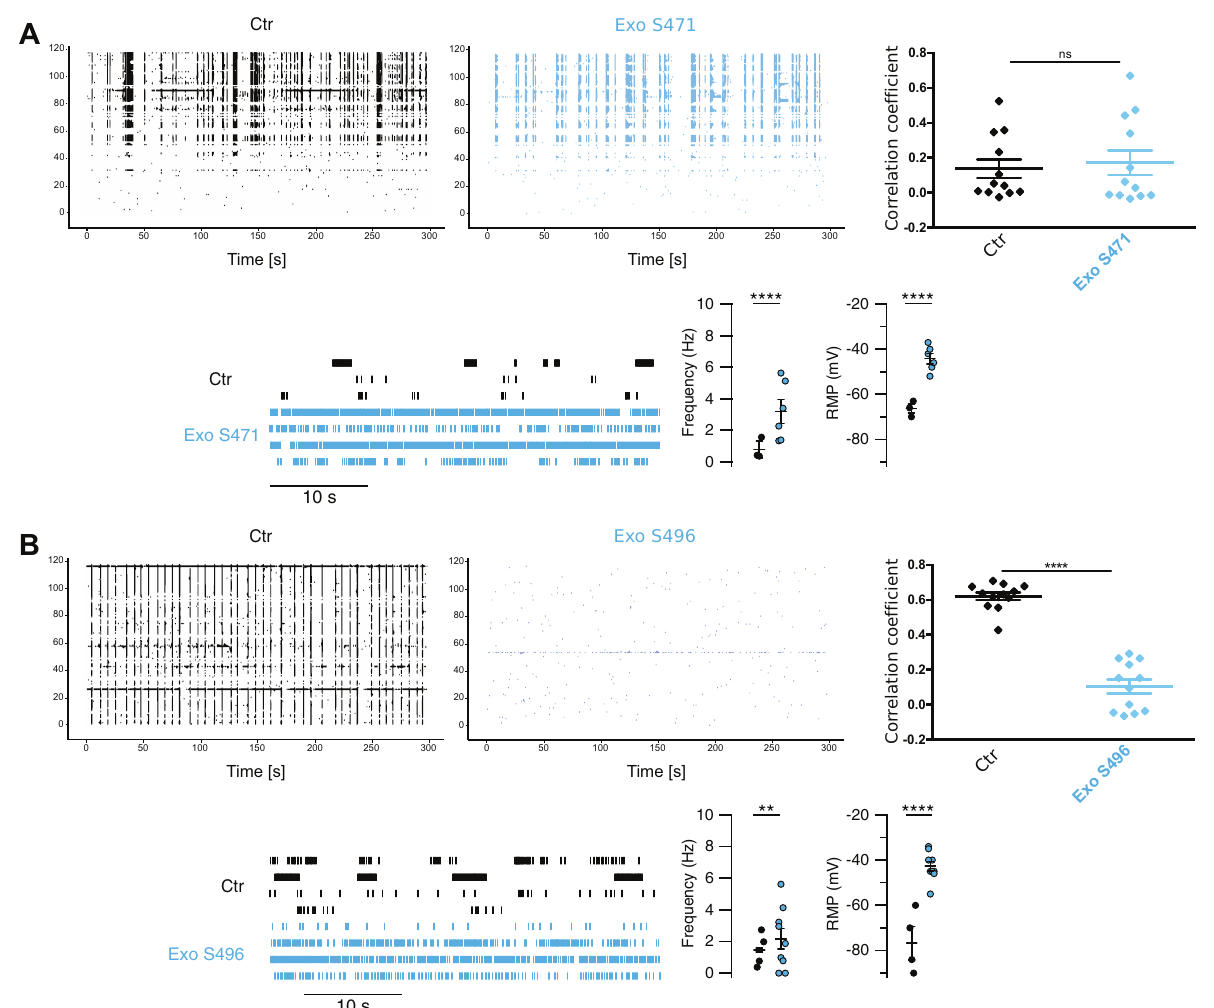
Fig. 7 Exosomes derived from HGG patients have variable effects on neuronal excitability and synchrony. Network-wide and single-cell electrophysiological phenotype of neurons treated with exosomes from HGG patients ( A : S471; B : S496). Raster plots from MEA recordings and correlation coef fi cients among spike times are shown in the upper panels, before (Ctr, black) and 24 h after exosome incubation (Exo, blue). The y axes on the raster plots represent channels ’ numbers. The average correlation values across 10 channels were calculated and their distribution compared using Wilcoxon – Mann – Whitney U test; ** p < 0.001, **** p < 0.0001; n = 12, average of 10 channels. In the lower panels, raster plots of single-cell neuronal activity are shown for neurons treated with patients ’ exosomes and the respective controls. The distributions of fi ring rate (Hz) and resting membrane potentials (RMP) are shown; statistics were performed using the Wilcoxon – Mann – Whitney U test; ** p < 0.001, **** p < 0.0001; n = 3/6 for S471, 4/9 for S496 (neurons analyzed in Ctr/Exo samples, respectively). (Fig. 6A – C, blue traces, upper middle panels ): the correlation coef fi cient among spike times was signi fi cantly decreased in all three cases (Fig. 6A – C, upper right graphs ). These results are consistent with the ones obtained from U87 exosomes (Fig. 2). In the case of exosomes derived from patient S479, we observed large waves of electrical activity invading the entire network: these ‘ superbursts ’ appeared to be the collective expression at the network level of the pro-epileptic behavior induced by exosomes at the single cell level (see Fig. 3). Given the lower heterogeneity of hippocampal neurons in culture compared to that of cortical neurons [42, 43], we performed intracellular recordings on hippocampal neurons treated under the same experimental conditions. Neurons treated with exosomes from LGG patients exhibited a more depolarized resting membrane potential (RMP) and episodes of vigorous spontaneous fi ring (Fig. 6A – C bottom panels ).